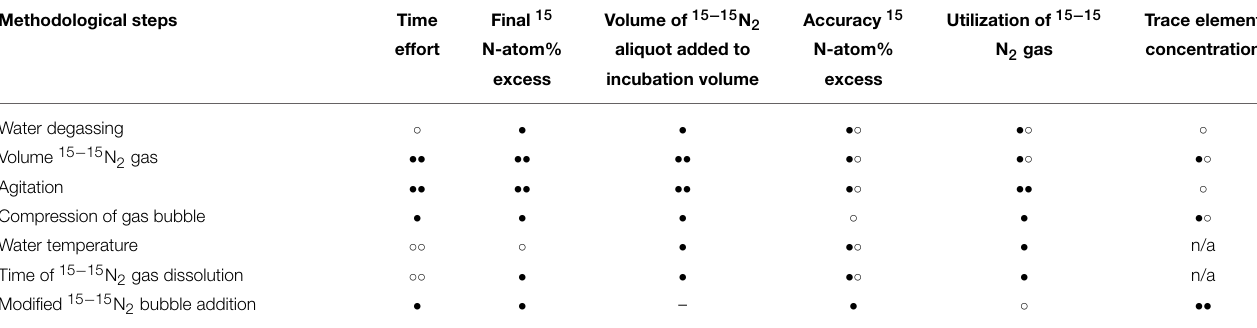
TABLE 2 | Rating of optional methodological steps for the preparation of 15 − 15 N 2 -enriched water according to their positive ( •• ) or negative ( ◦◦ ) effects on parameters which are of importance for N 2 fixation assays. Methodological